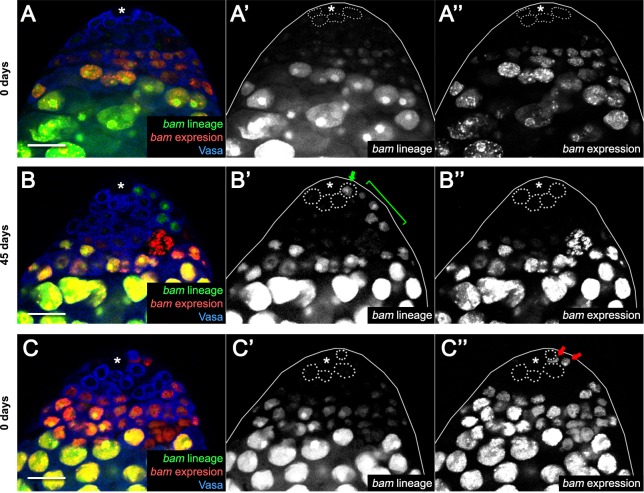
Lineage and real-time expression analysis of bam-Gal4 in aging and starvation.(A–A”) bam-Gal4 driving the expression ubiP63E-FRT-stop-FRT-GFP lineage tracing cassette marker (A’) and of UAS-RFP for real-time expression analysis (A”) in 0 day-old flies. Note the absence of bam-lineage-positive (i.e., dedifferentiated) cells among the GSCs (dotted lines) in contact with the niche (asterisk). (B–B”) The same analysis as in (A) but for 45-day-old unmated flies. Note the presence of bam-lineage-positive (i.e., dedifferentiated) cells among the GSCs (arrow) actively proliferating and giving rise to spermatogonial cysts (bracket). Note also that the bam-lineage-positive GSC has become negative for real-time expression of bam-Gal4, as it does not express RFP (B”). (C–C”) Example of spurious somatic real-time expression of bam in somatic support cells (CySCs, arrows) at 0 days. Scale bars represent 20 µm.